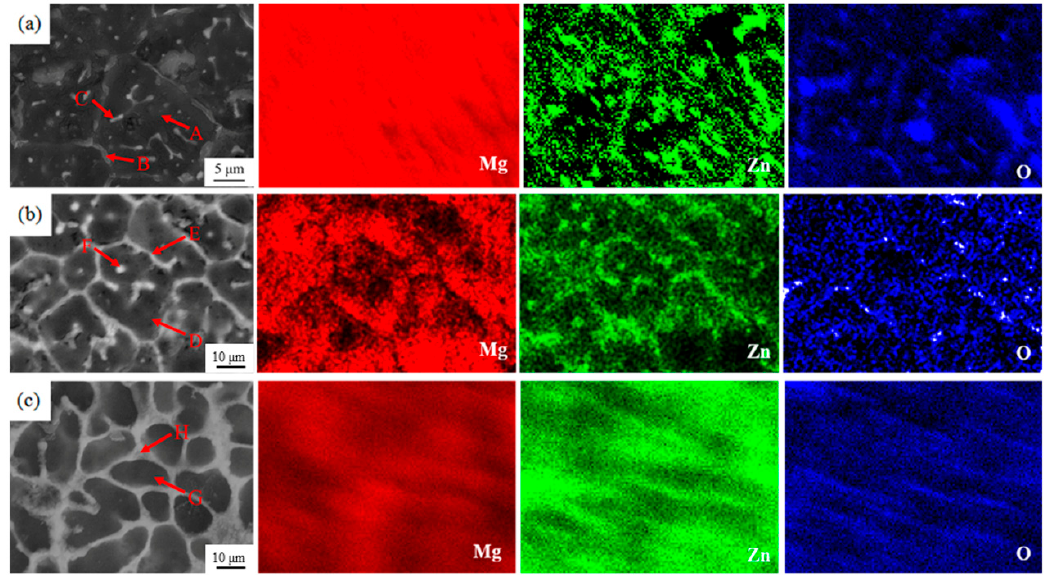
Figure 8. SEM and corresponding EDS images of the LAMed Mg-Zn-Zr alloys. ( a ) E1, ( b ) E2, ( c ) E3. Table 4. EDS results marked A–H in Figure 8.